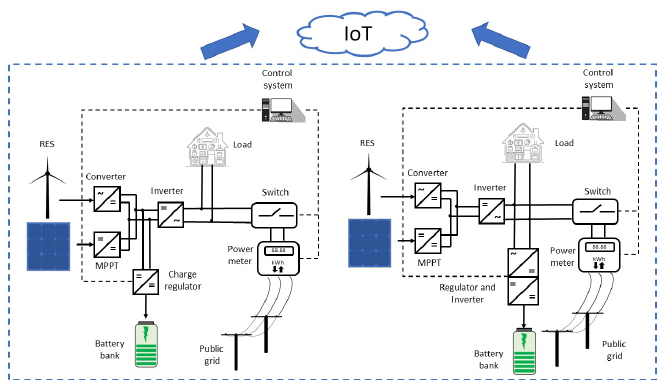
Figure 1. Simplified diagram of an MG with a DC-link ( left ) and a AC-link ( right ) of an ESS.